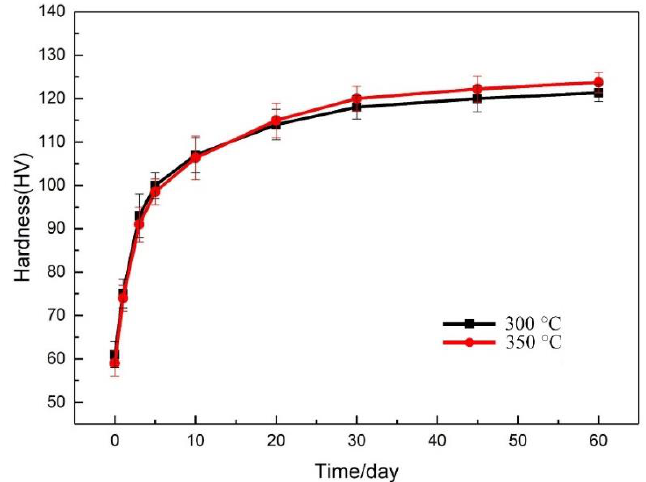
Figure 3. The evolution of micro-hardness in samples during natural aging.